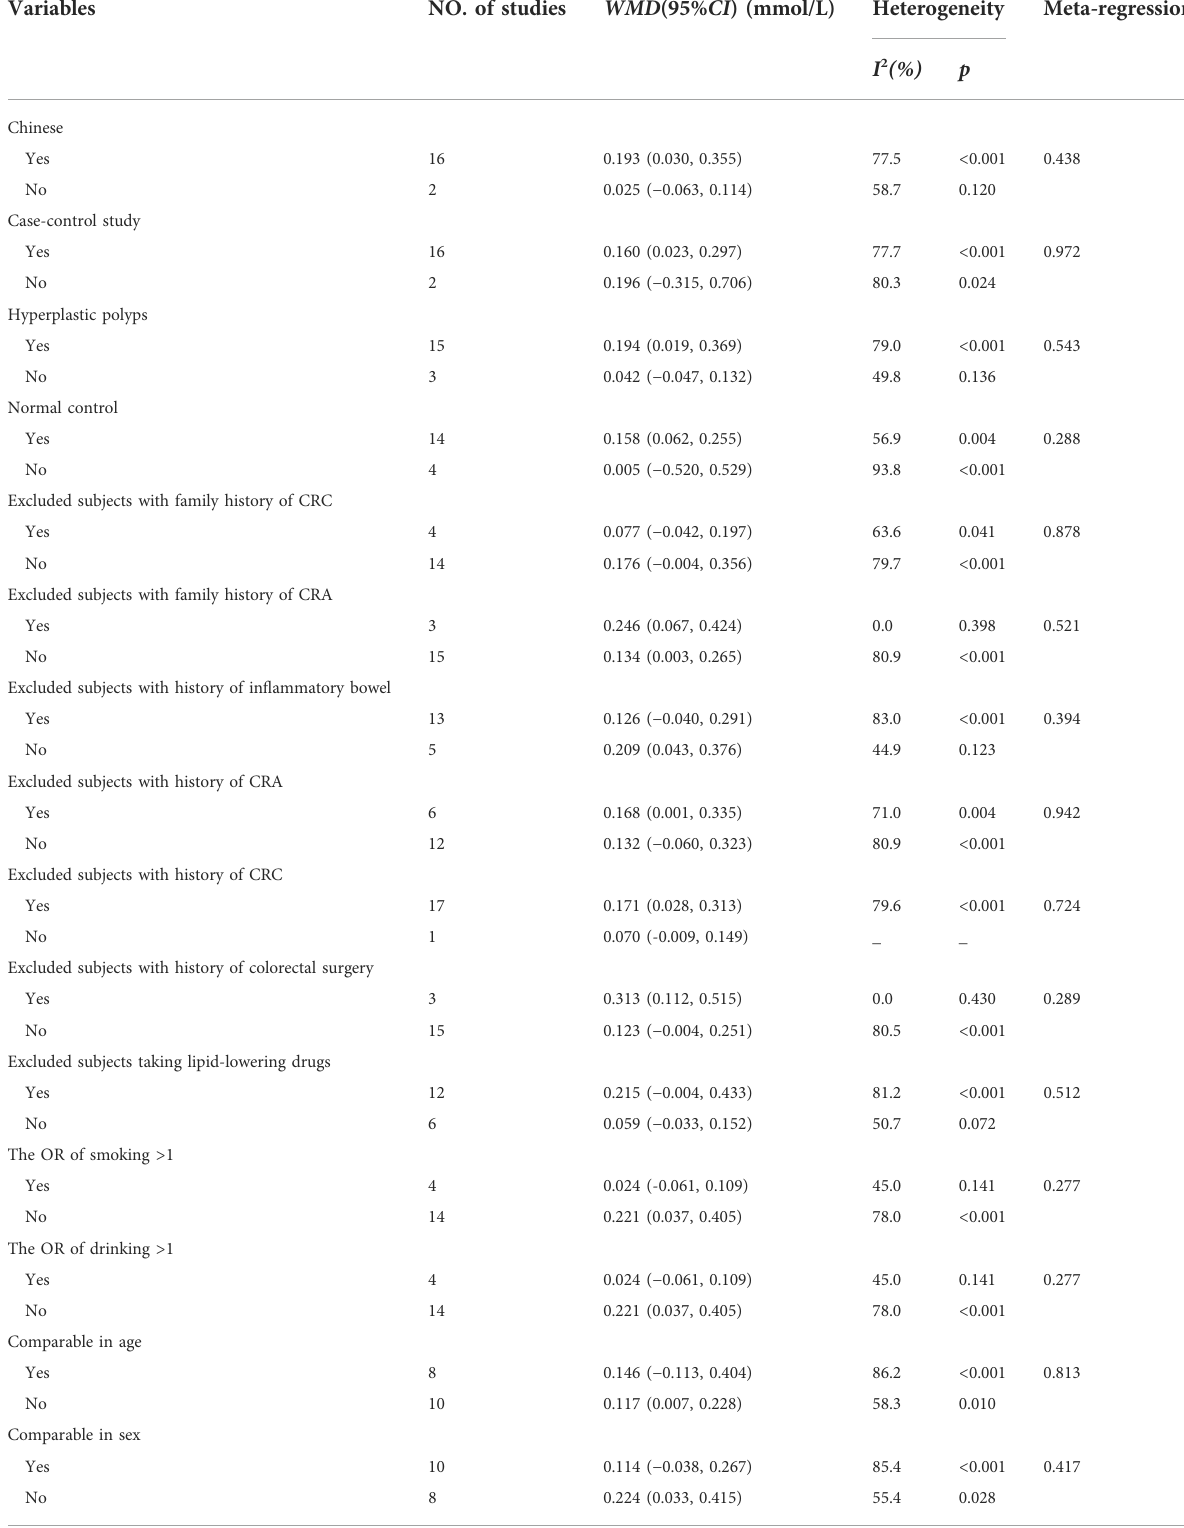
TABLE 3 Heterogeneity source analyses for mean difference of